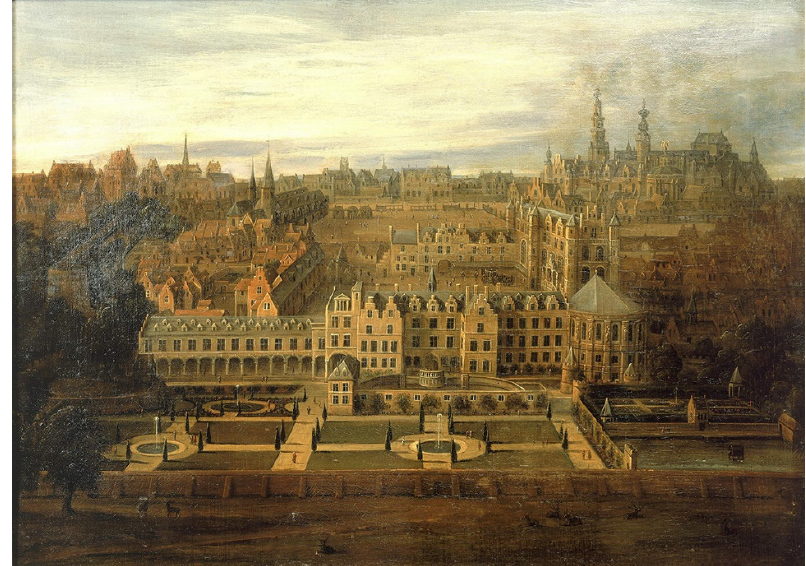
Figure 3. A representation of the palace which dominated the city of Brussels, the object of this research.